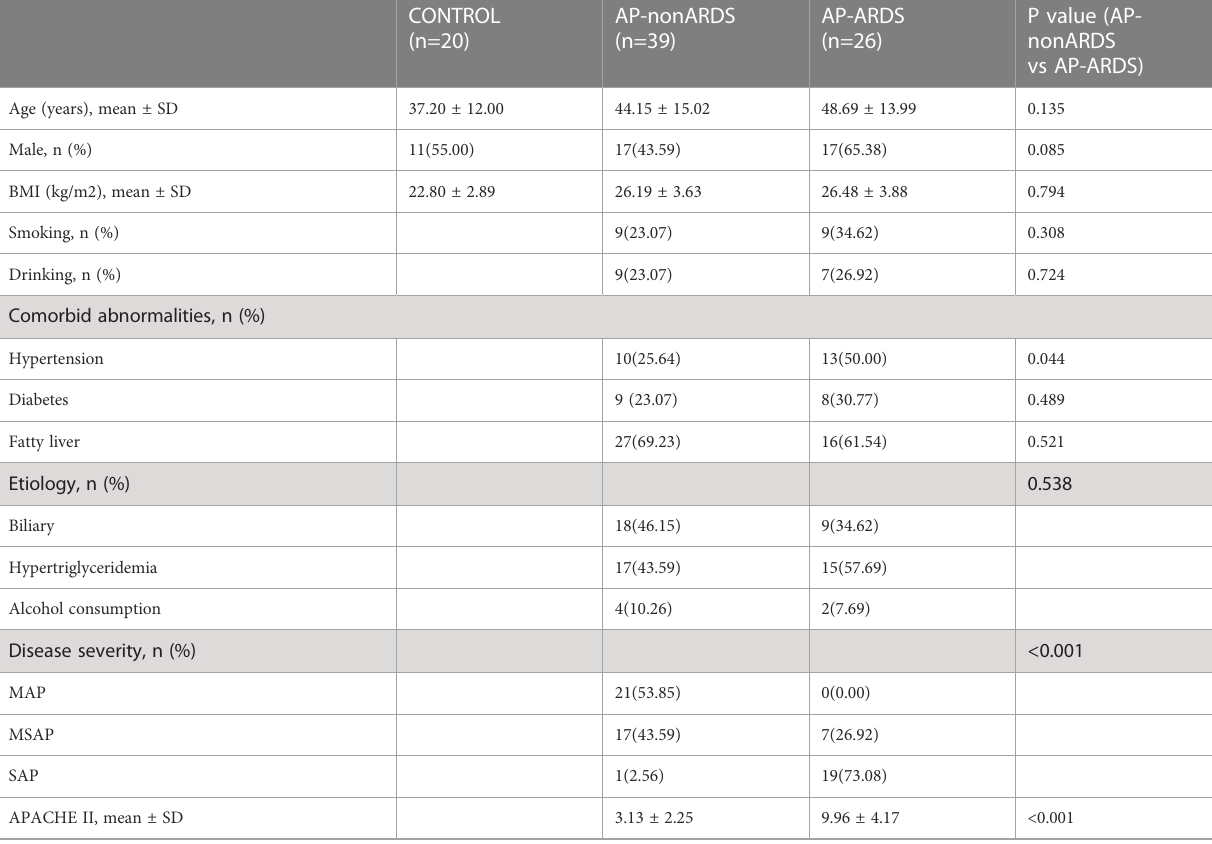
TABLE 1 Demographic and clinical characteristics of health control, AP-nonARDS, and AP-ARDS